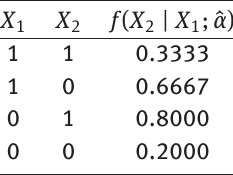
Table A2: PMF for imputation function h().